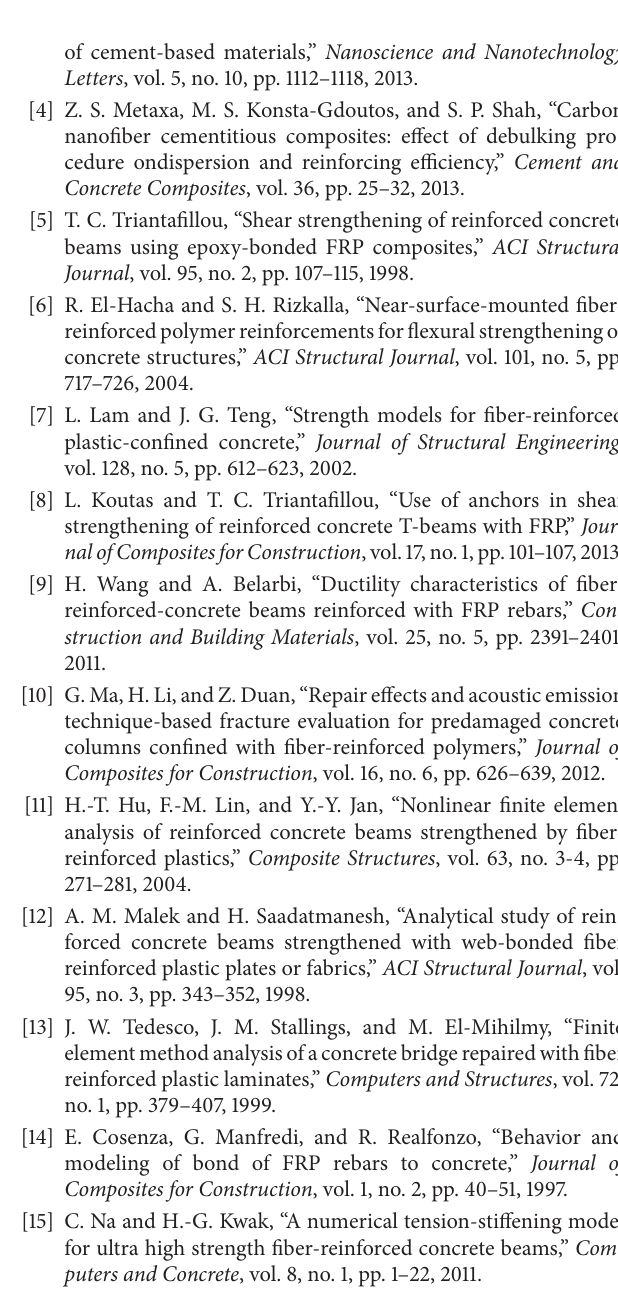
Figure 8: Strain of concrete, FRP plate, and resin